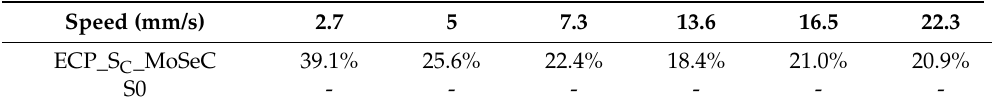
Table 9. Percentage performance of the ECP_S C _MoSeC specimen in comparison to S0 (positive values are decreases in friction related to the smooth and uncoated specimen).